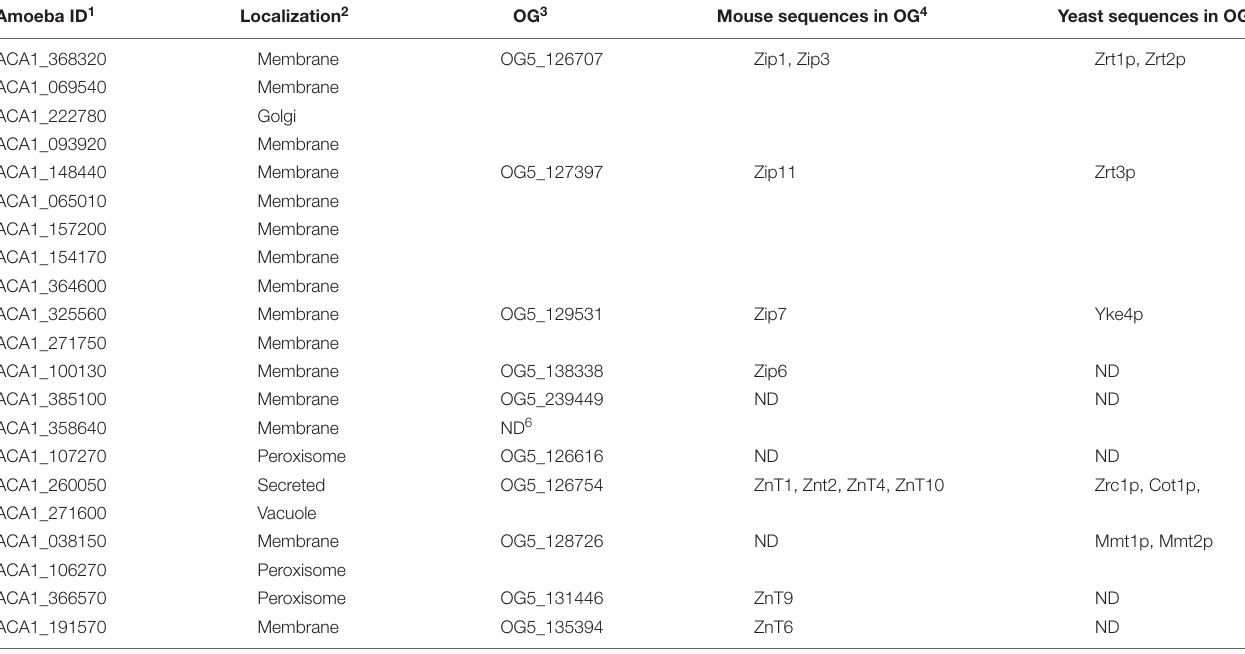
TABLE 1 | Description of possible orthologs and predicted subcellular localization of amoeba zinc transporters. Amoeba ID 1 Localization 2 OG 3 Mouse sequences in OG 4 Yeast sequences in OG